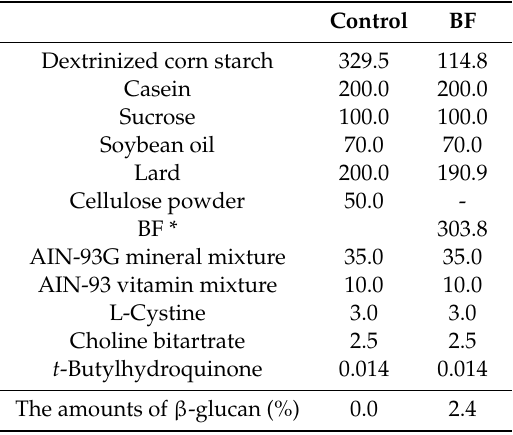
Table 2. Composition of the control and BF experimental diets (g /